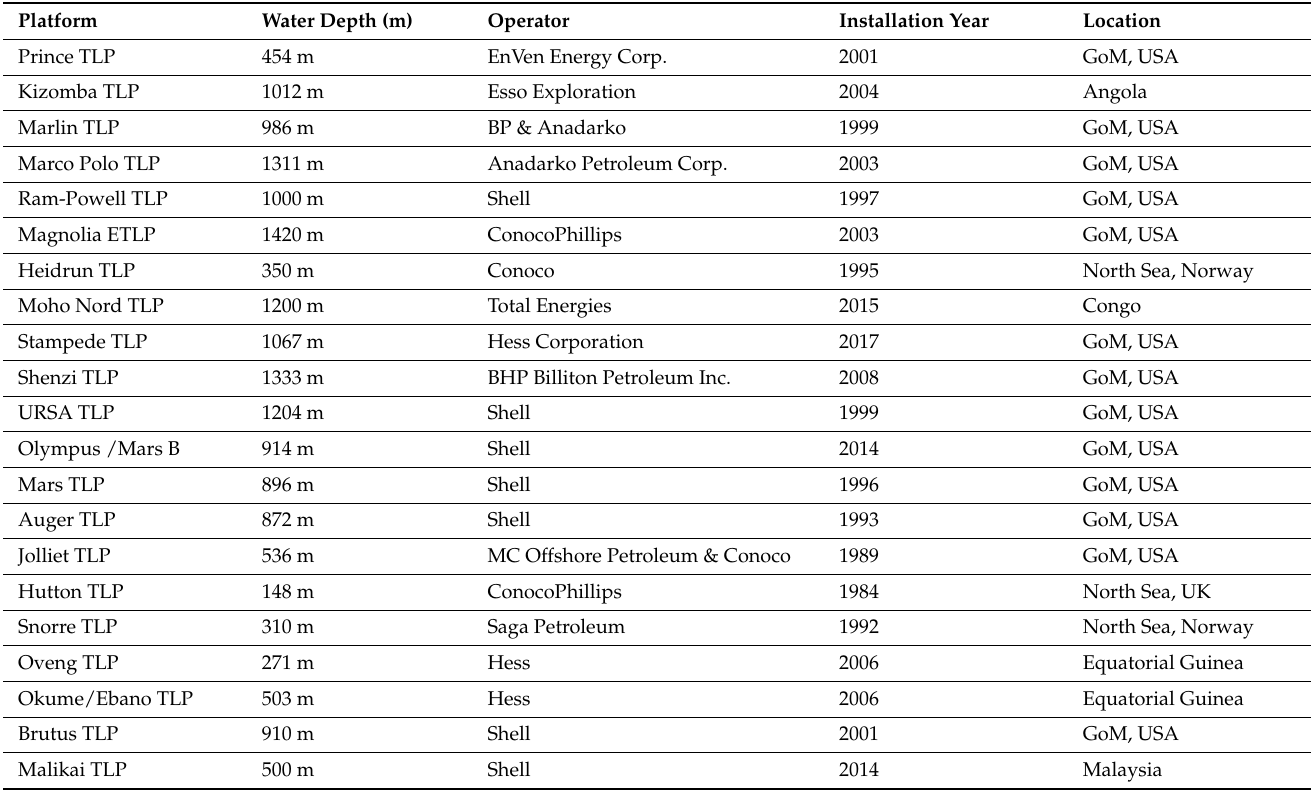
Table 10. List of some tension leg platforms constructed.